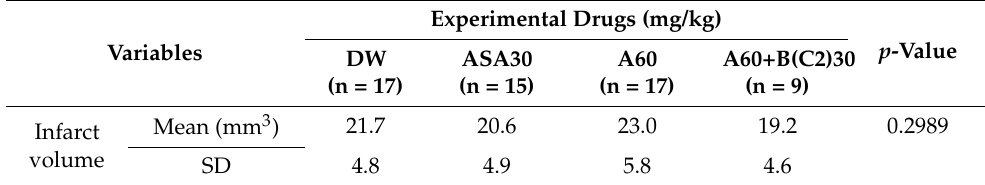
Table 4. Effects of experimental drug A60+B(C2) 30 mg/kg on infarct volume after pMCAO.